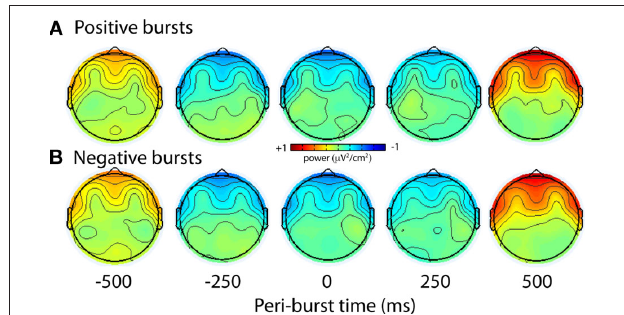
FIGuRE 15 | Topographical distribution of theta (4–7 Hz) activity during eyes-open condition. The scalp topography of theta-band (4–7 Hz) power preceding and following the bursts is highly consistent for both positive (A) and negative (B) bursts, with relative theta-band suppression occurring at frontal and lateral frontal regions surrounding the time of the alpha asymmetry